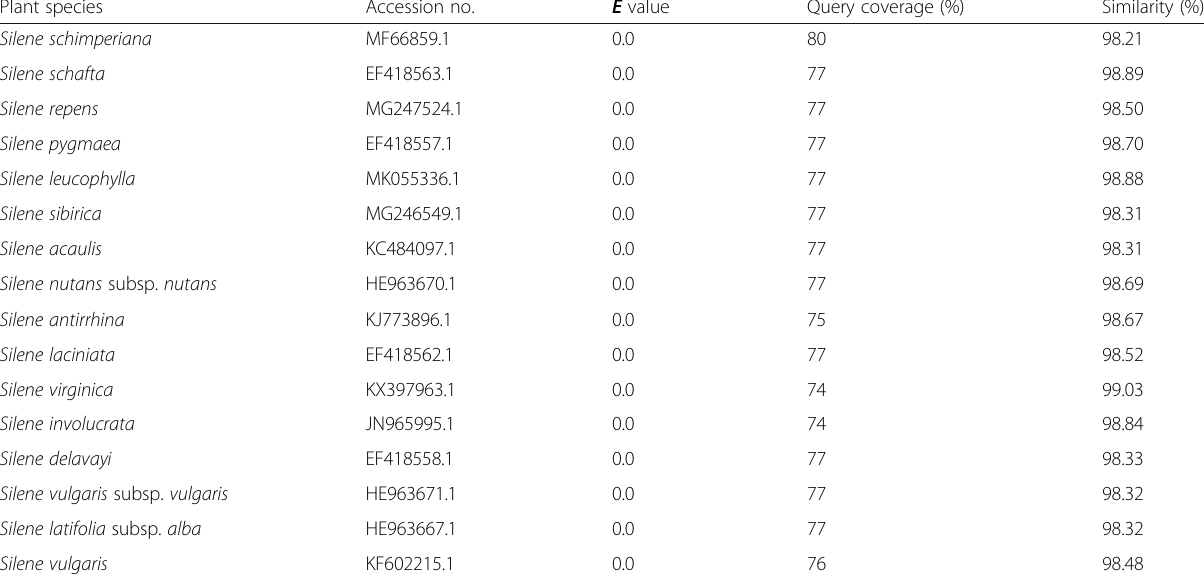
Table 6 DNA barcode of 1,5-bisphosphate carboxylase/oxygenase large subunit ( rbcL ) downloaded from GenBank database including plant species with similarity percentage of more than 98.2%